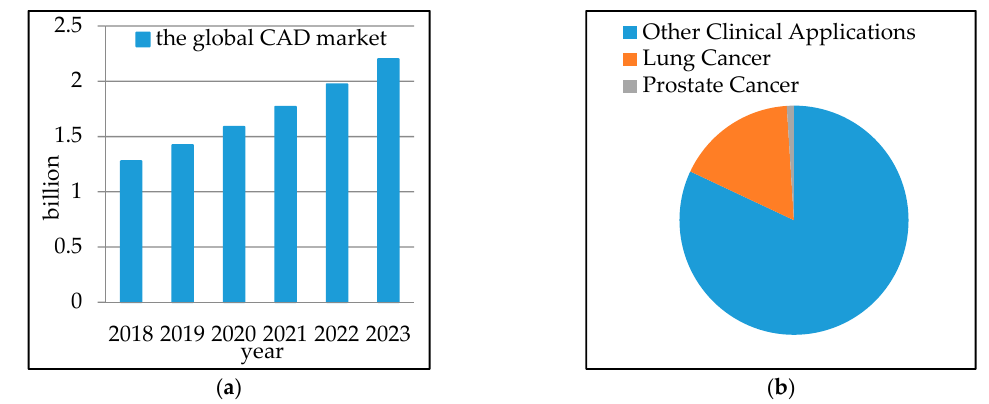
Figure 2. Demonstration of the CAD market trend and its market share of lung cancer. ( a ) prediction of global CAD market, ( b ) proportion of different CAD systems applications.